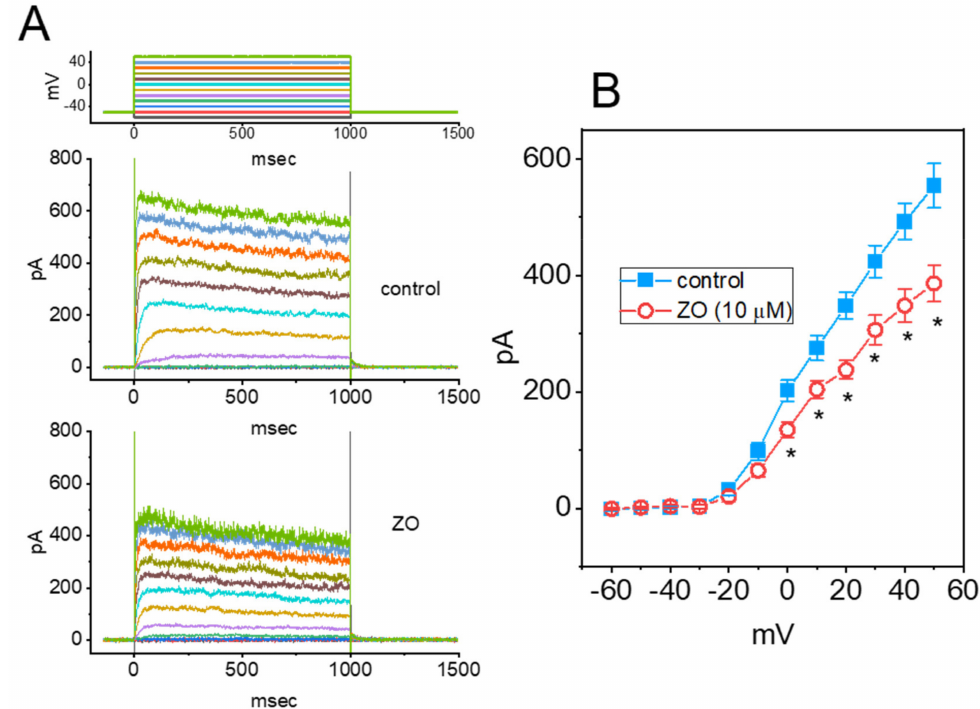
Figure 7. Mild inhibition of a Delayed-Rectified K + Current ( I K(DR) ) caused by ZO in GH 3 cells. In these experiments, we kept cells bathed in Ca 2+ -free Tyrode’s solution, and the recording pipette was filled with K + -containing solution. As the whole-cell configuration was commenced, we voltage-clamped the examined cell at − 50 mV and applied various voltage pulses ranging between − 60 and +50 mV at 10 mV. ( A ) Representative current traces obtained in the control period (upper) and after application of 10 µ M OZ (lower). The uppermost part indicates the applied voltage-clamp protocol. ( B ) The mean I–V relationship of I K(DR) taken without ( (cid:4) ) or with ( ) the addition of 10 µ M (cid:35) ZO (mean ± SEM; n = 8 for each point). The current amplitude was taken at the endpoint of each voltage command. * Significantly different from the controls taken at the same potential ( p <